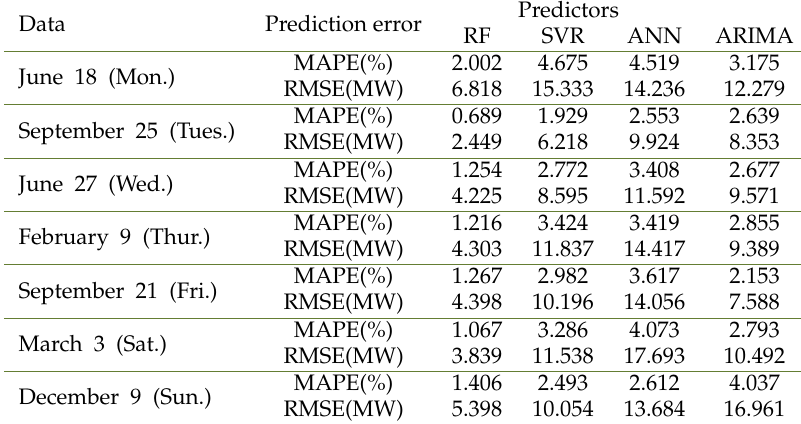
Table 3. Prediction error of different predictors of the selected seven test days with really attempt when day-ahead pre- diction is